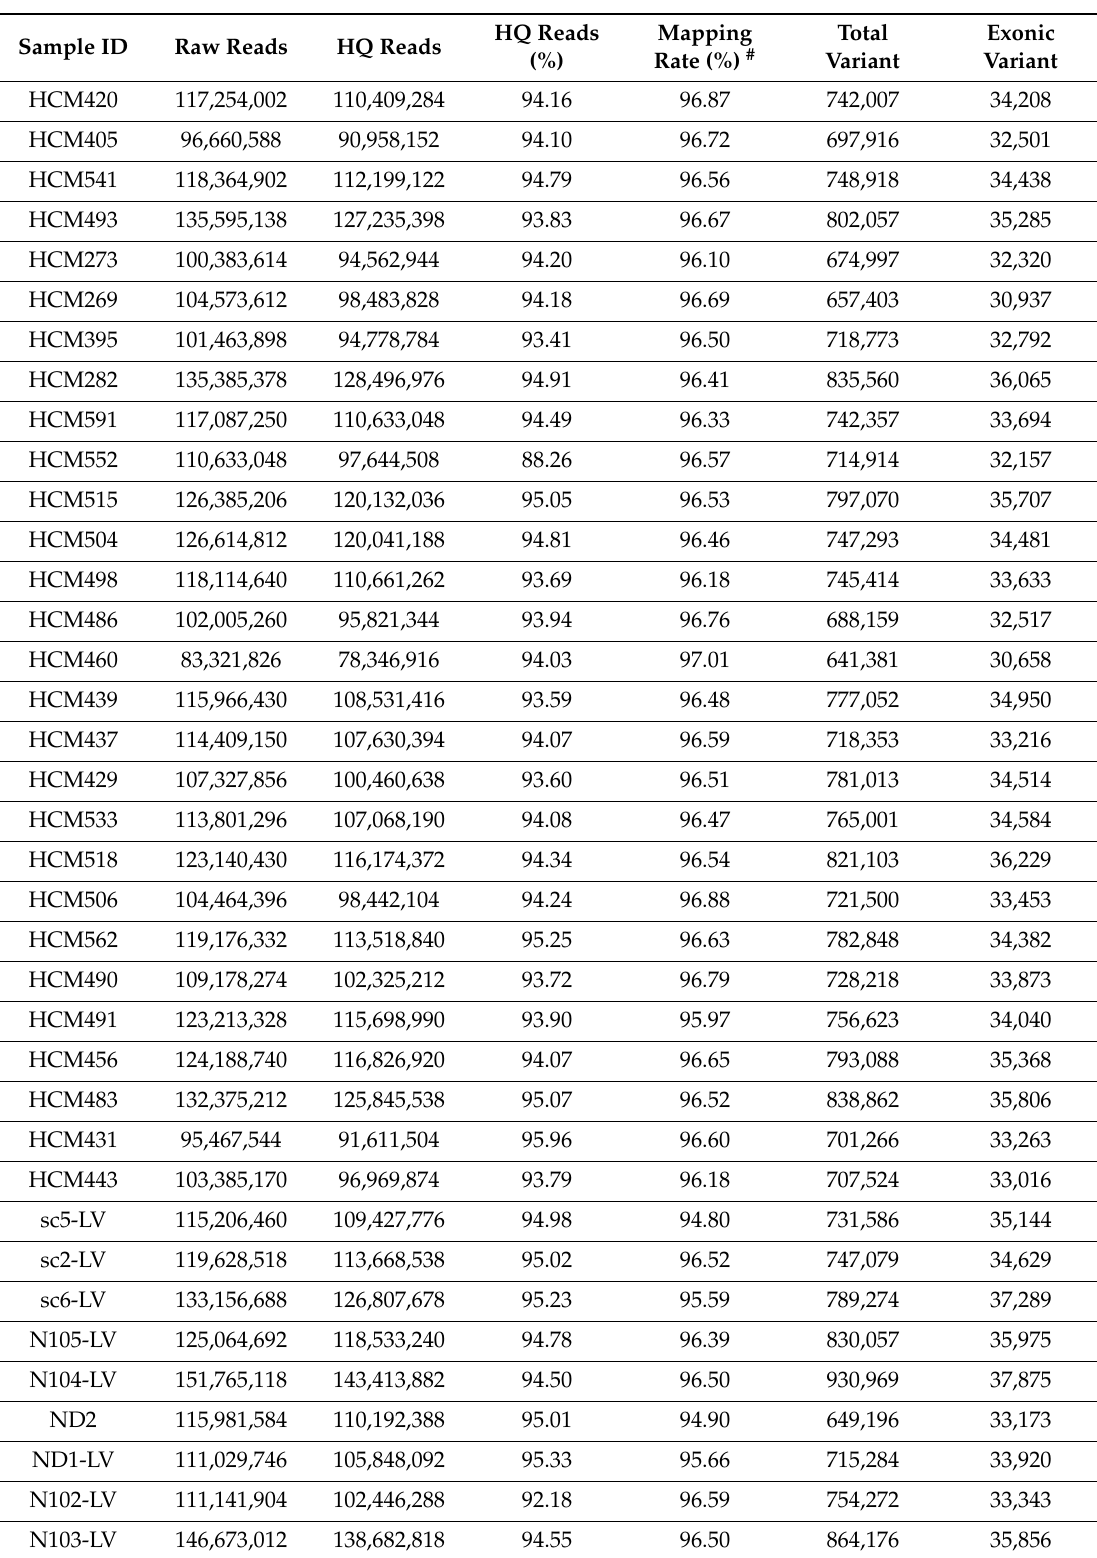
Table 2. Summary statistics of RNA-seq